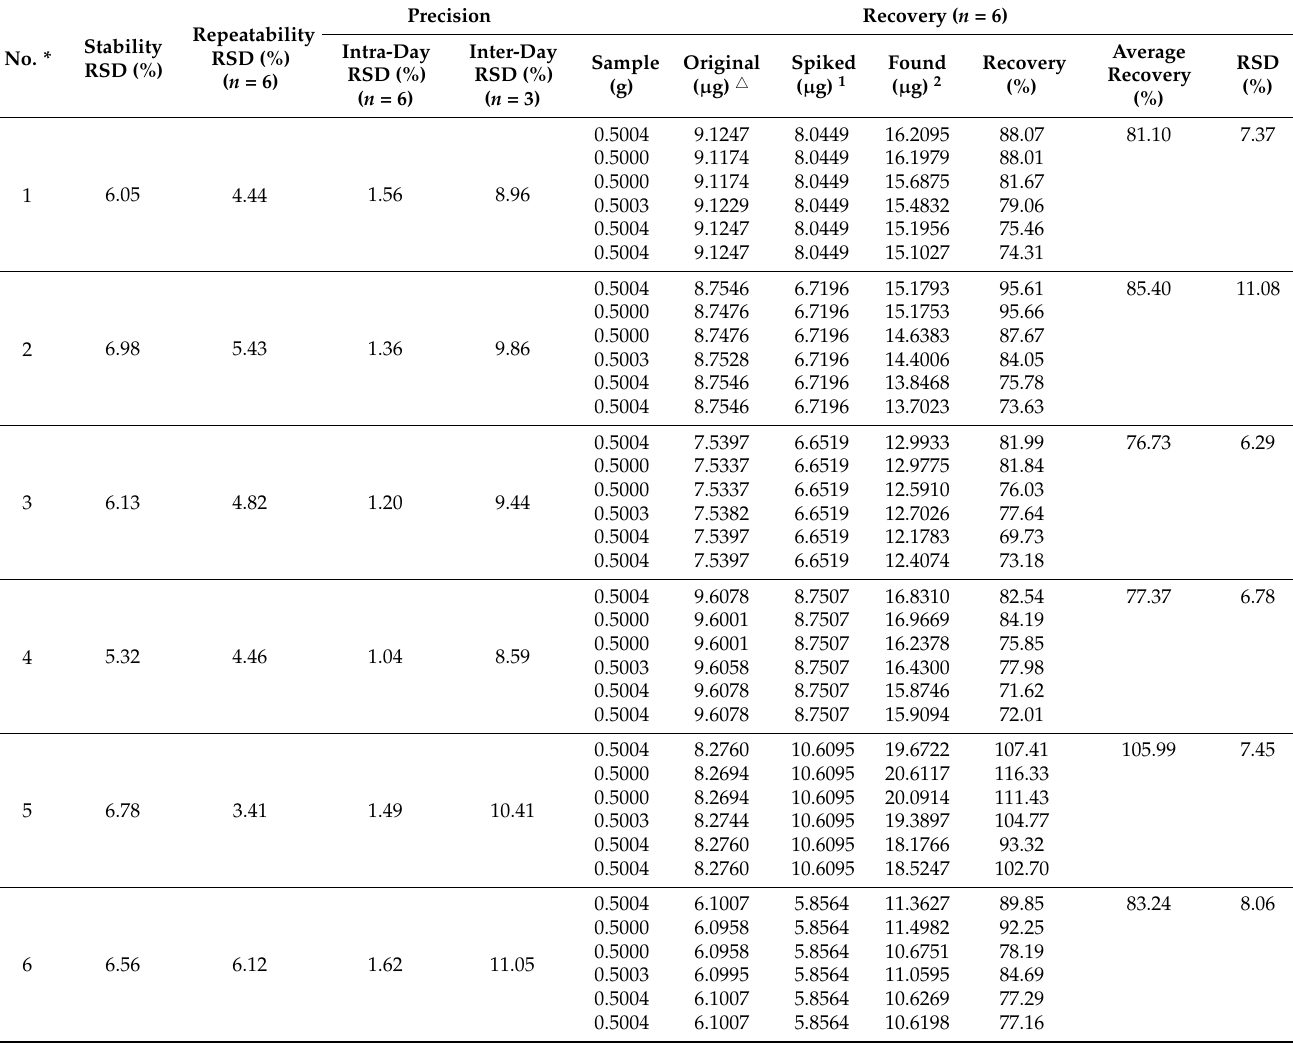
Table 2. The stability, repeatability, precision, and recovery of 6 compounds in the detection of total